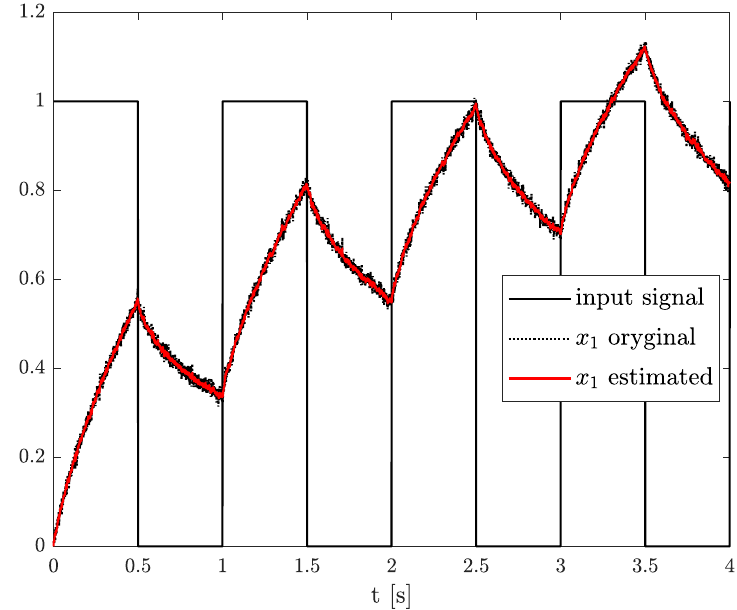
Figure 11. Original and estimated state variables from Example